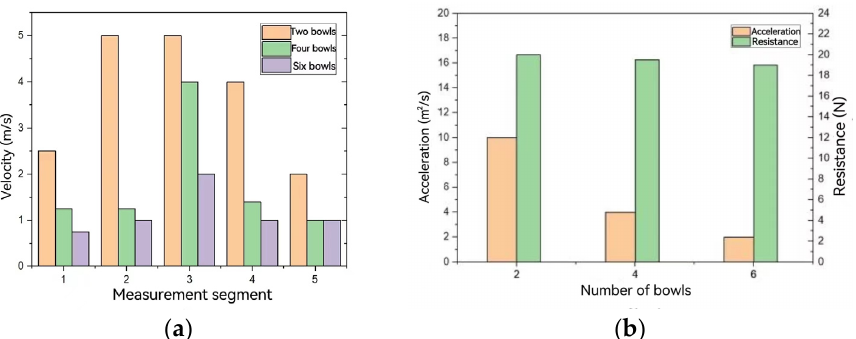
Point A pressure curve; ( b ) Point B pressure curve; ( c ) Point C pressure curve; ( d ) Point D pressure curve.